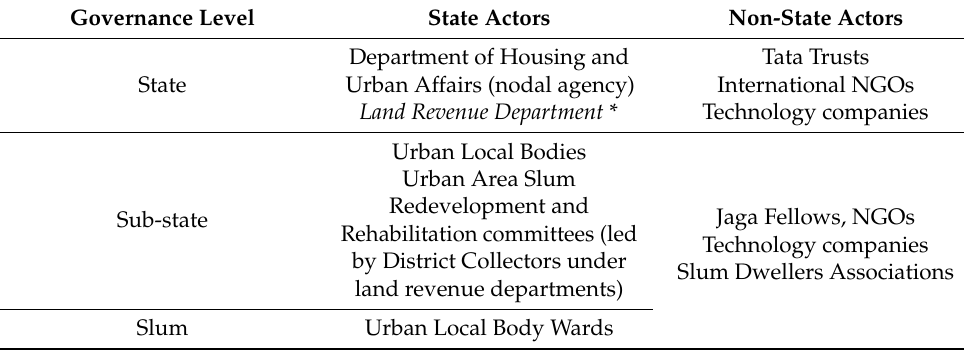
Table 4. Decentralized land administration structure for